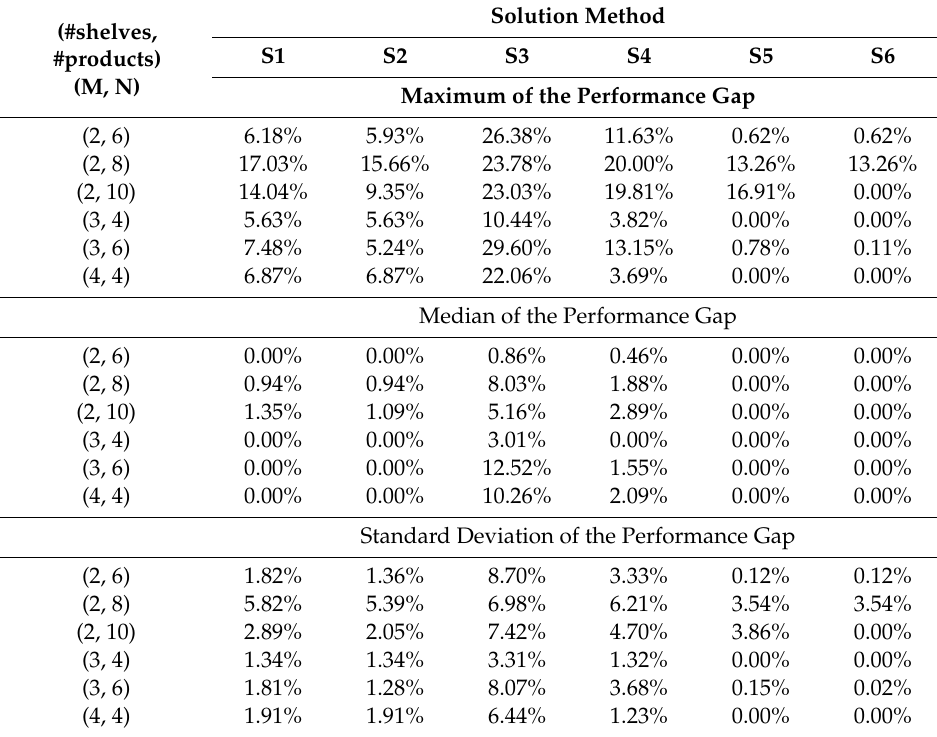
Table 8. The max, median, and standard deviation of the performance gap under di ff erent (M,